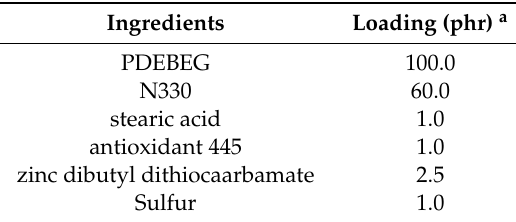
Table 2. Recipe of the PDEBEG/CB composites.